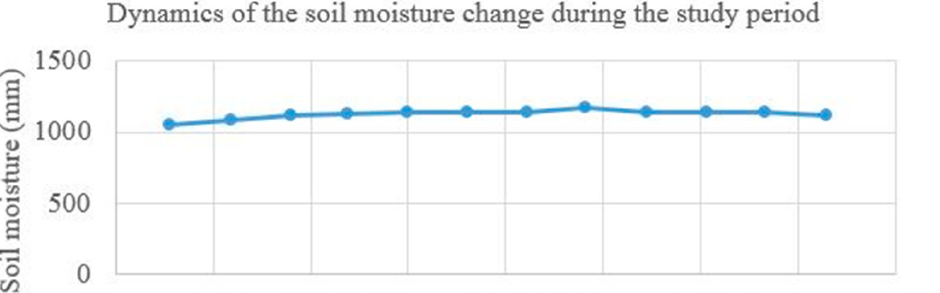
Figure 2. Soil moisture status during the study period.